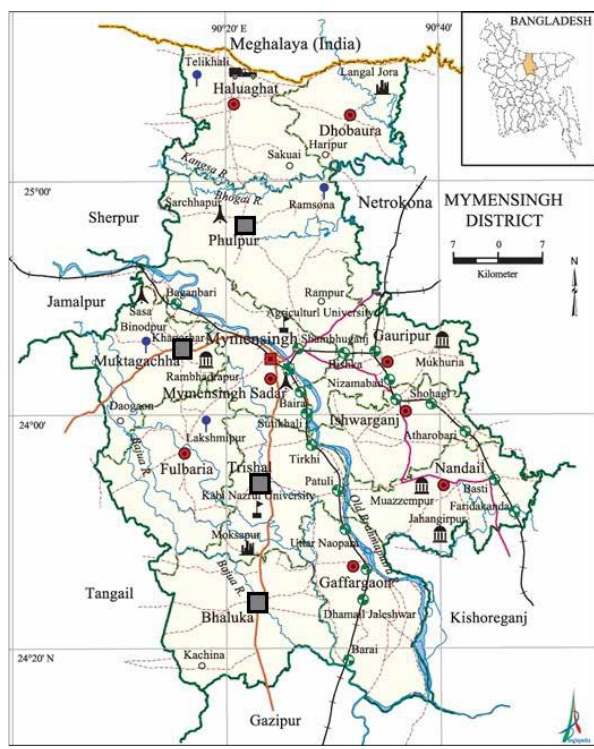
Figure 1: Map of the study areas (Rectangle marked area) (Source: Mymensingh District